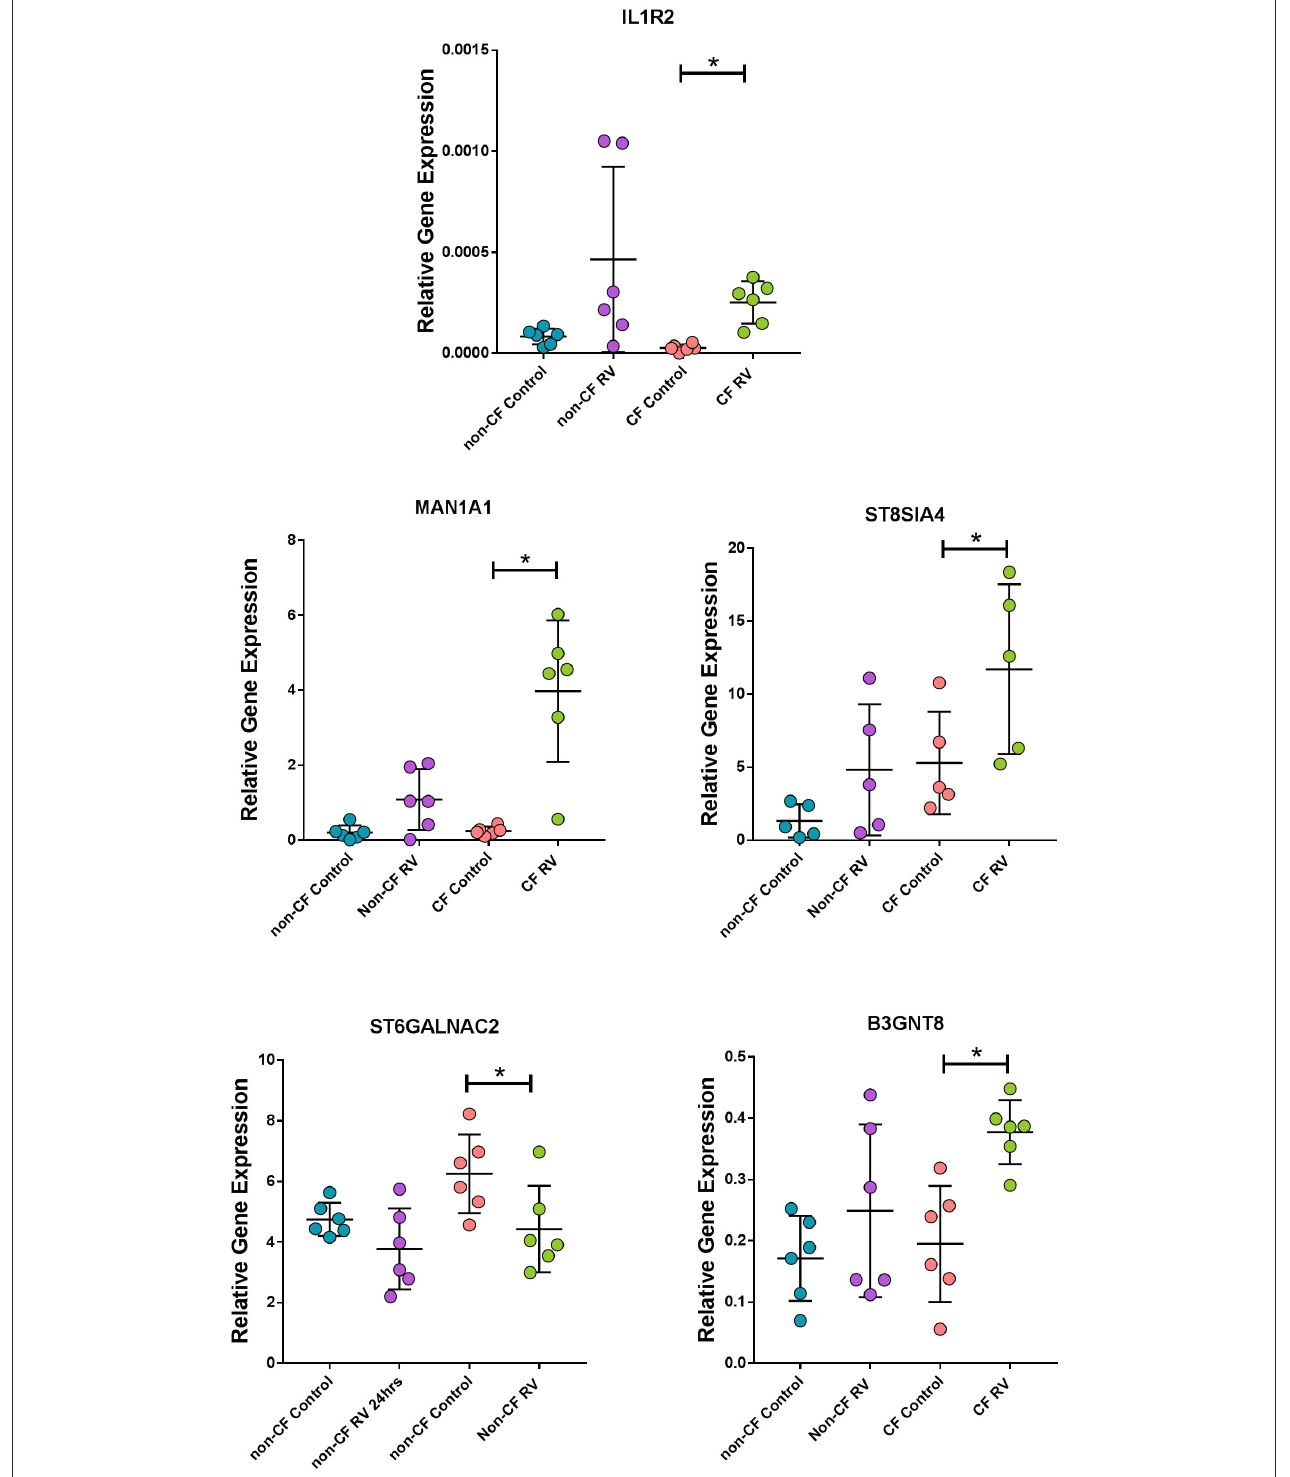
FIGURE 6 | Corroboration of uniquely expressed genes by CF AEC in fully differentiated cultures. Gene expression of the top unique gene IL1R2 as well as mannosidase ( MAN1A1 ), sialyltransferases ( ST8SIA4 and ST6GALNAC2 ), and acetylglucosaminyltransferase ( B3GNT8 ), were uniquely altered in CF air–liquid interface cultures when infected with rhinovirus (RV) for 24h. Data points represent individual samples for non-CF controls (turquoise), non-CF infected (purple), CF control (coral), and CF infected (green). Expression of all genes were normalized to the housekeeping gene PPIA (49). *Indicates p < 0.05 by one-way ANOVA following normal distribution